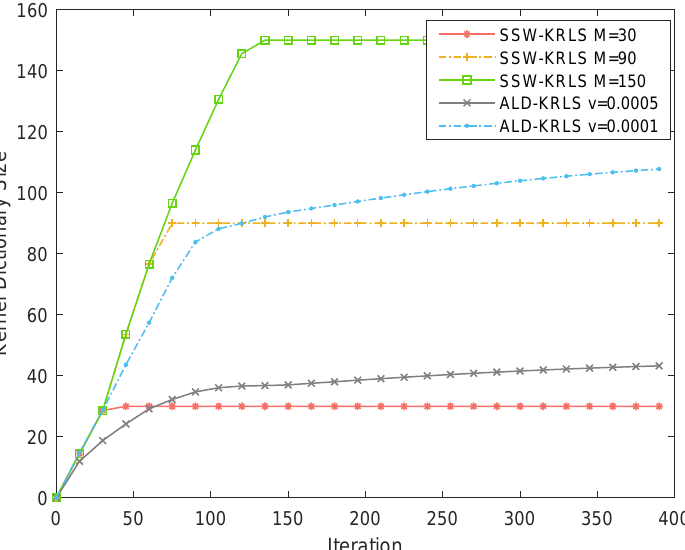
Figure 6. The kernel dictionary size of the proposed SSW-KRLS algorithm and ALD-KRLS algorithm varies with the number of iterations. β = 0.97, N t = 64, N r = 4.